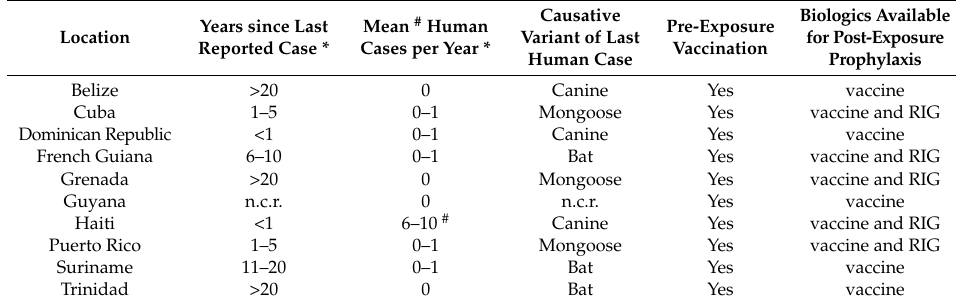
Table 2. Human rabies cases in the Caribbean: case frequency and availability of human rabies biologics for pre-and post-exposure prophylaxis reported in the